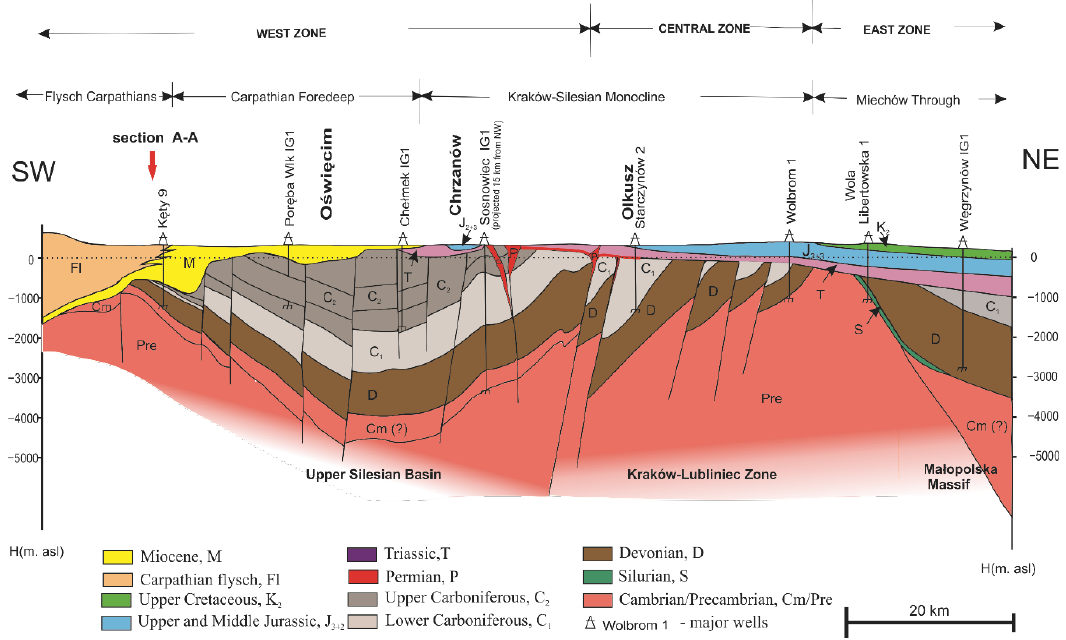
Figure 4. Schematic B–B geological cross-section through the area of analysis (based on PGNiG SA and PIG borehole data, CBDG PIG-PIB portal and according to [1,7,27]—location in Figure 1). Apart from the differences in structure visible in the geological cross-sections presented, there are also clear differences in complex lithology.